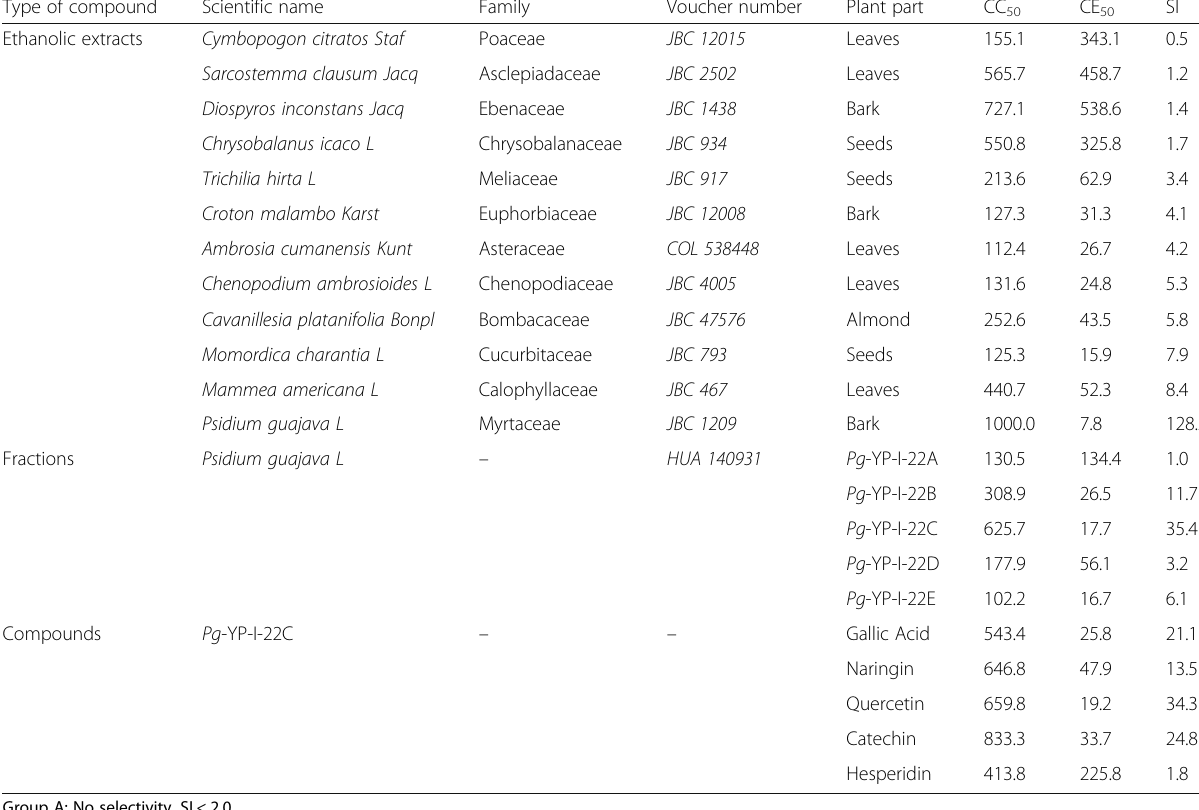
Table 1 Cytotoxic concentration 50% (CC 50) , effective concentration 50% (EC 50) , and selectivity index ( SI) values of the evaluated ethanolic extracts, fractions, and compounds in VERO cells infected with DENV-2/NG Type of